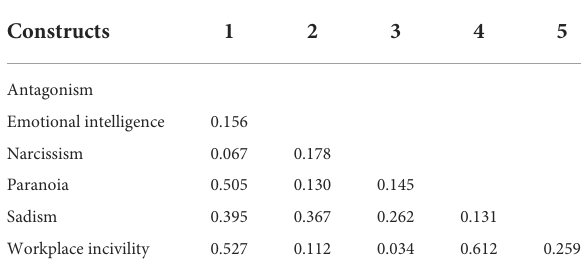
TABLE 3 Discriminant